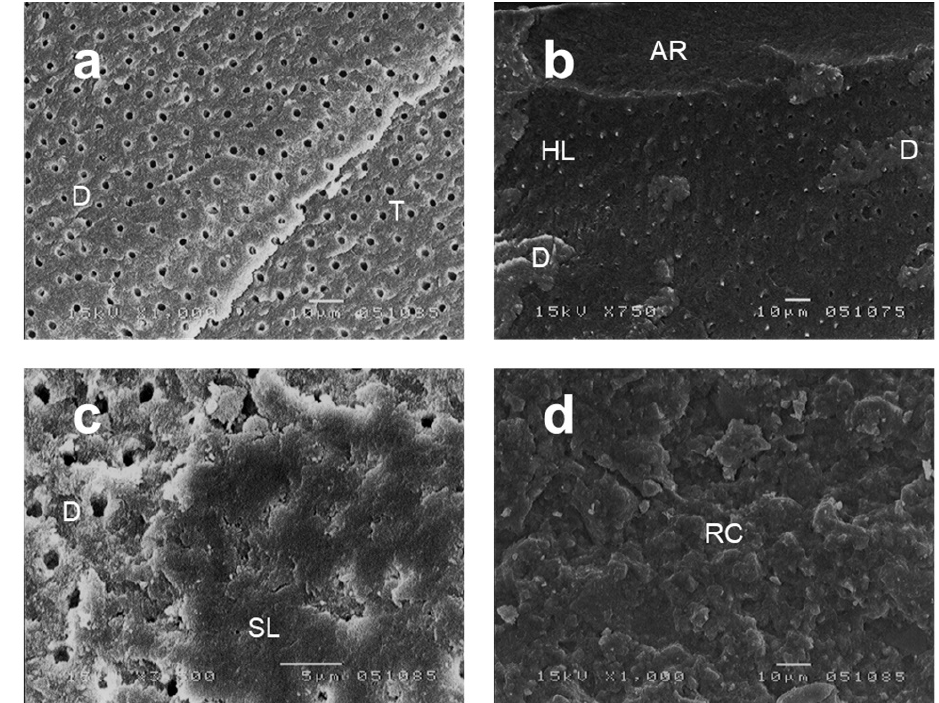
Figure 3. Representative scanning electron microscopy (SEM) images of the fracture interfaces used in the classification of the failure patterns ( a – d ) ( a , d : 1000 × , b: 750 × , c: 3500 × magnification), adapted from Otake 2010. ( a ) Failure in the dentin (D) at the fractured surface. Exposed dentinal tubules can be seen. ( b ) SEM image showing three types of failure patterns: cohesive failure in adhesive resin (AR), cohesive failure in dentin (D), and failure in the hybrid layer (HL). ( c ) Fractured surface of DS1 showing fracture in the smear layer (SL). ( d ) Failure in the resin composite (RC) at the fractured surface.